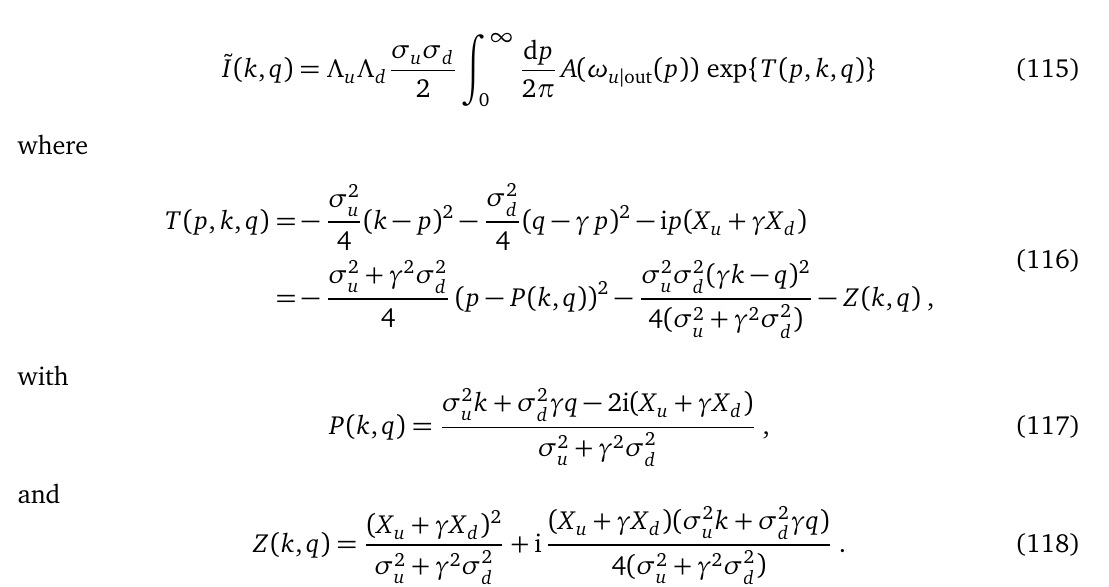
/ V ( > u | out d 2 | out